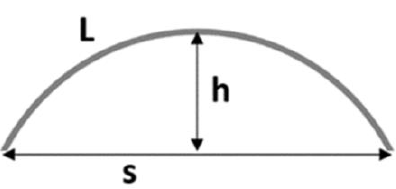
Figure 2. Graphical representation of the membrane deflection model. Value s, or the span of the circular arch, is the inner CellDrum applicator diameter. Value h is the deflection that can be measured by distance sensors.